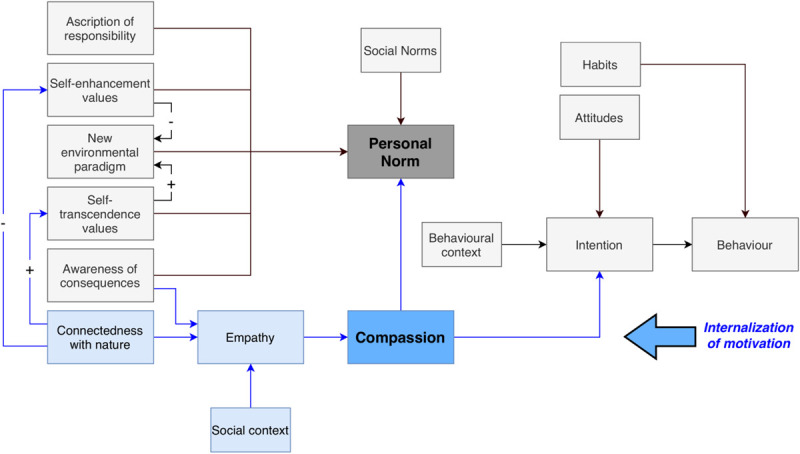
The 2-pathway model of PEB (Thiermann and Sheate, 2020a).